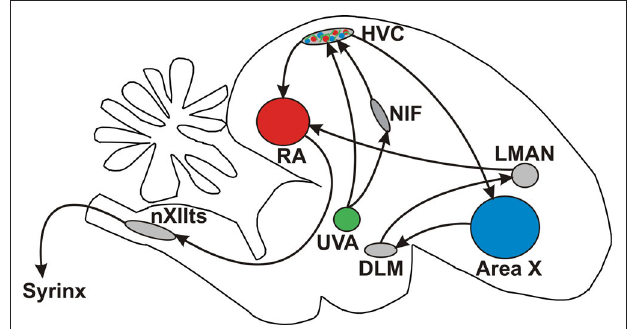
Figure 1 | Schematic representation of the songbird brain. Highlighted are regions involved in song learning and song production. Injections were made in RA (red), UVA (green), and Area X